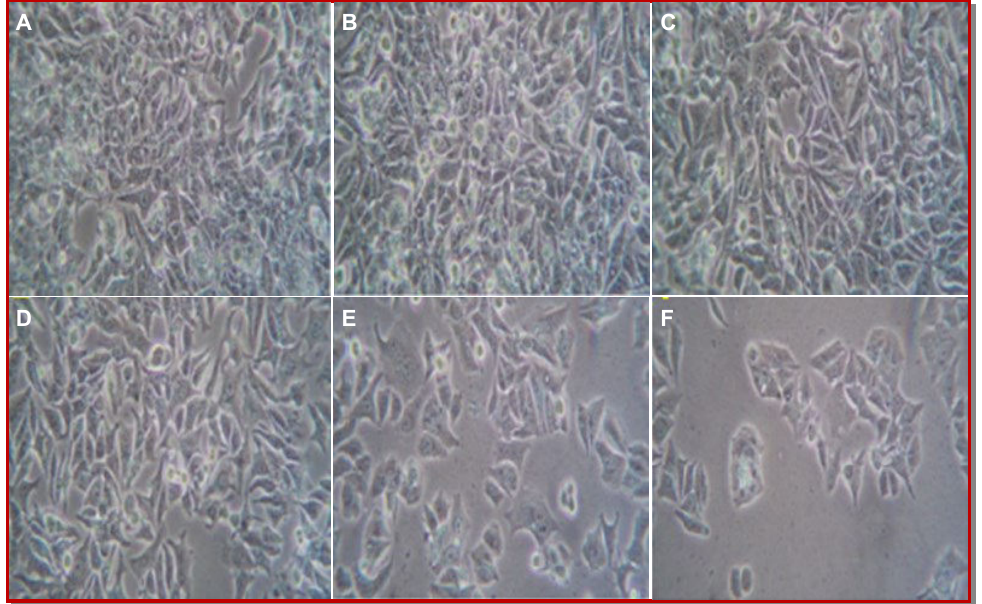
Figure 2: Morphologic profiles of MCF-7 cell line treated with ethyl acetate extract of C. cupreum at various concentration: A- Con- trol; B- 10 µg/mL; C- 25 µg/mL; D- 50 µg/mL; E- 100 µg/mL; F- 150